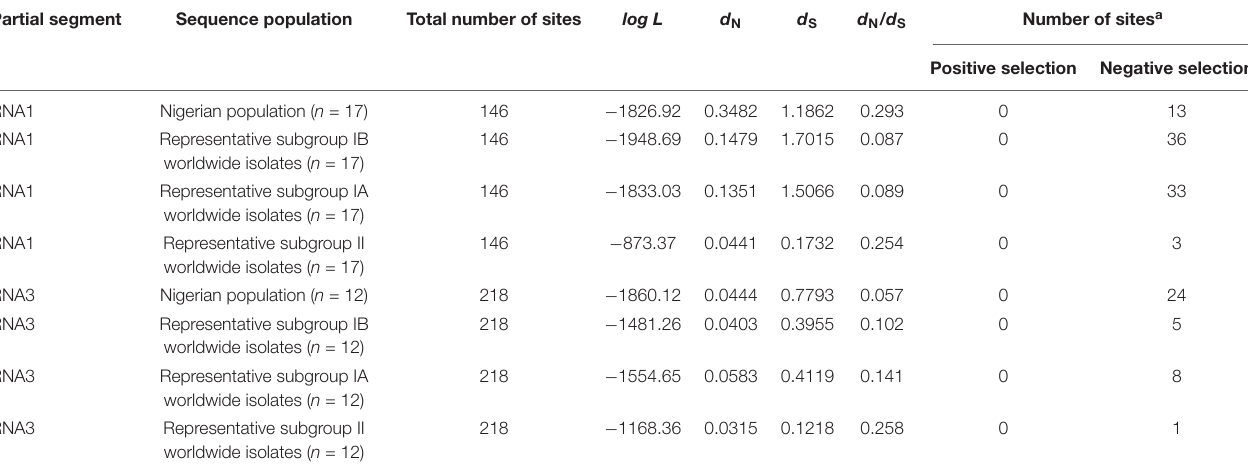
TABLE 7 | Occurrence of selection pressure within the Nigerian CMV population compared with other CMV isolates worldwide. Partial